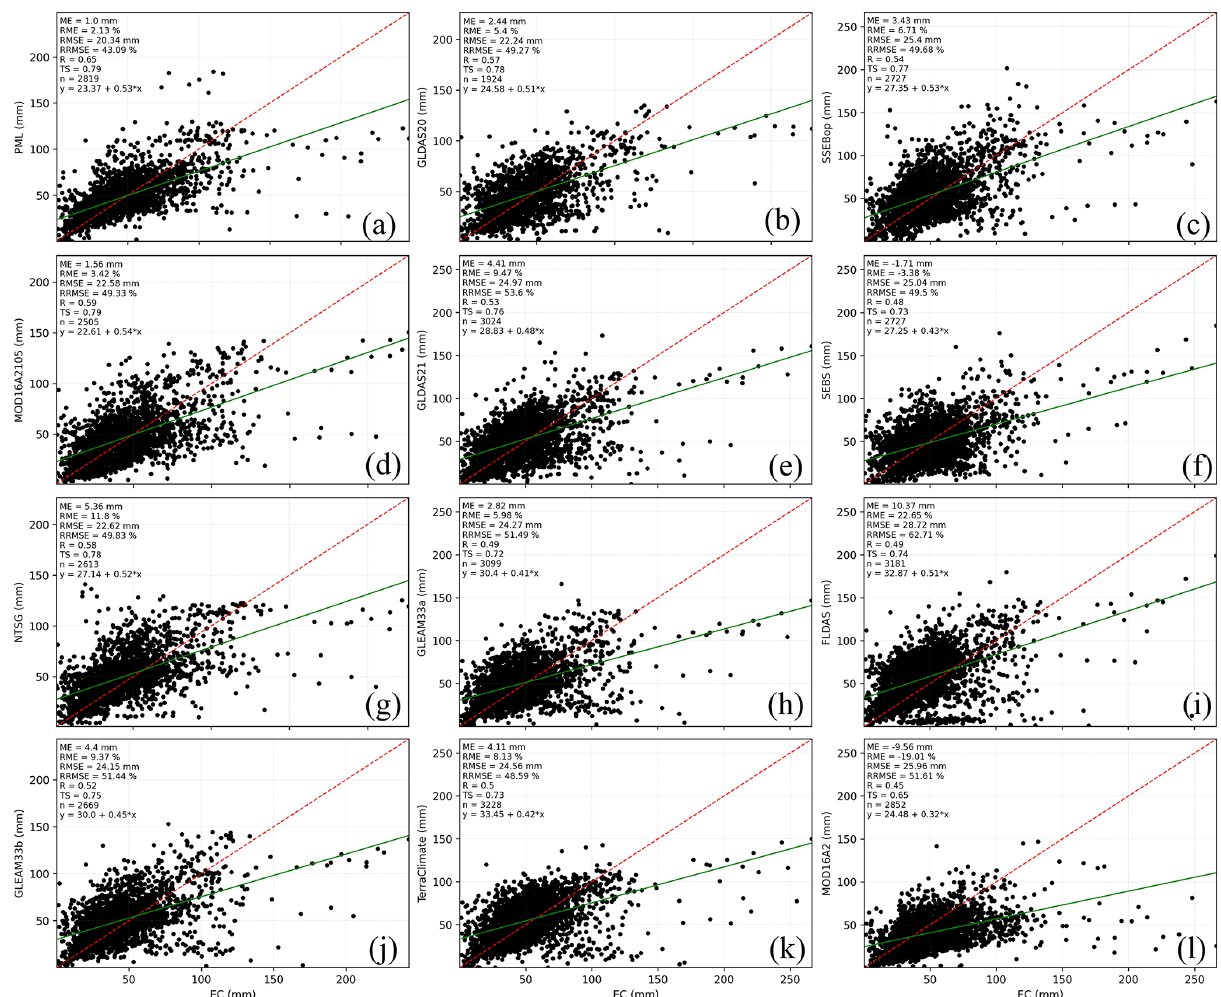
Figure 6. Annually ET products against flux EC ET aggregated for all sites (subplot labels as in Fig.